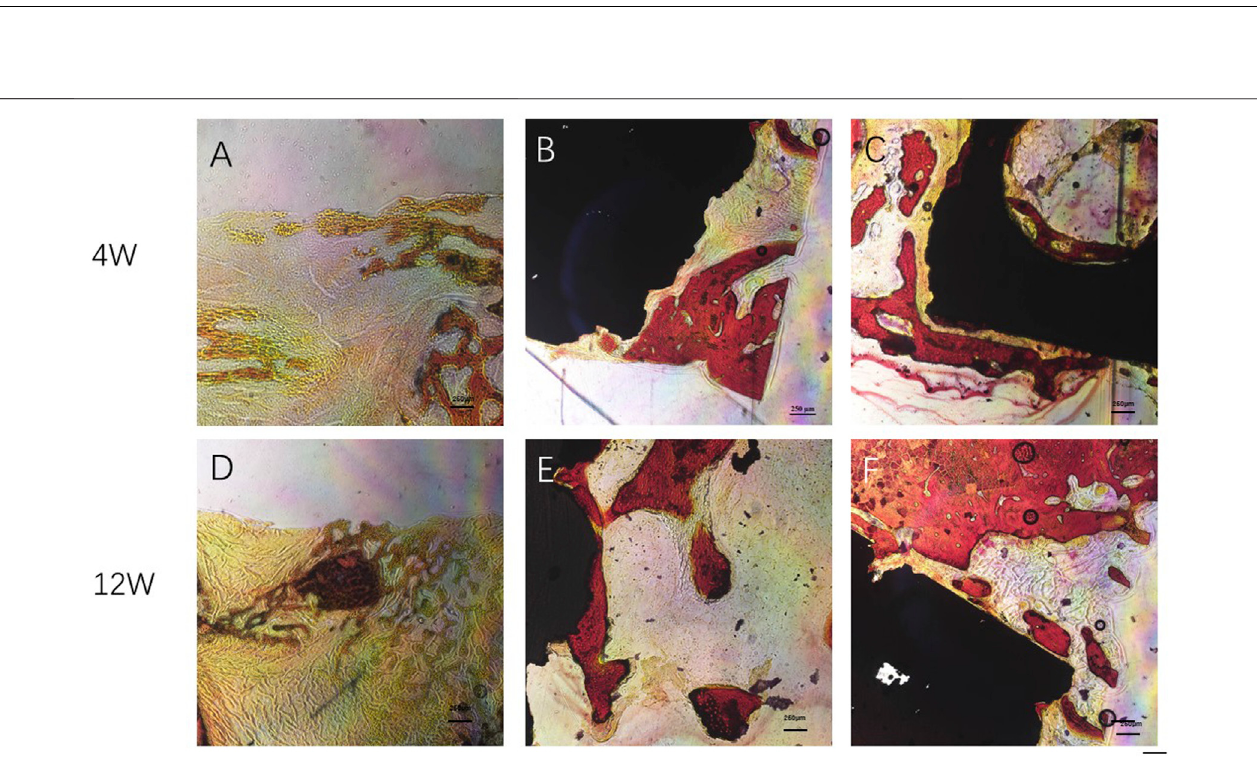
FIGURE13| VanGiesonstaining:Newbornbonetissueisstainedred. (A,D) Controlgroup; (B,E) Gr-Tigroup; (C,F) Gr-Ti/Exosgroup:asigni fi cantamountofnew bone tissue grew into the bone defect area and material pores of the Gr-Ti/Exos group.